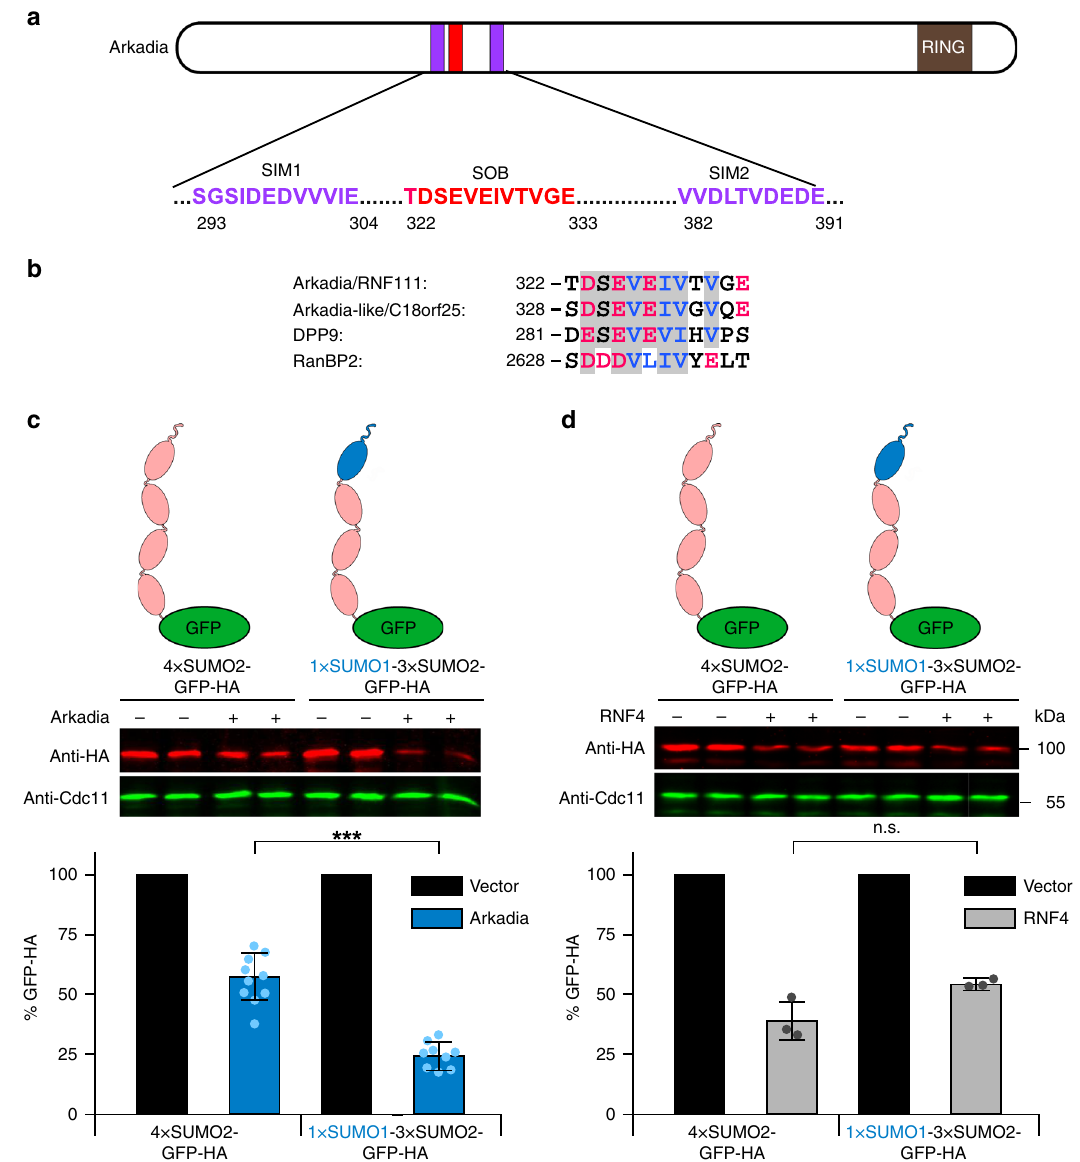
Fig. 1 Arkadia is a STUbL with a substrate preference distinct from RNF4. a Schematic representation of relevant domains and their positions in human Arkadia. b Alignment of SUMO-binding motifs from Arkadia, Arkadia-like 1 (ARKL1), DPP9, and RanBP2. Residues that are similar in at least the fi rst three of the molecules are shaded in gray. Acidic residues are shown in red, hydrophobic residues are shown in blue. c Analysis of substrate targeting by Arkadia upon expression in S. cerevisiae . HA-tagged GFP test substrates fused with their N-terminal ends to either 4xSUMO2 or a SUMO1-capped 3xSUMO2 chain were expressed in cells either transformed with an empty vector or with a plasmid expressing Arkadia. Cells were grown to log phase and extract proteins analyzed by quantitative anti-HA Western blotting. Endogenous Cdc11 protein levels were detected for normalization of loaded protein amounts. The middle panels show the Western blot images obtained for two independent transformants of each plasmid combination. The bottom panels show the results of quanti fi cations obtained with data for nine independent transformants each. Bars represent the means. Standard deviations (SD) are indicated by error bars. d Same as in c , but for RNF4 obtained with three independent transformants each. Three asterisks indicate signi fi cant differences with p -values < 0.001. n.s., not signi fi cant. Statistical signi fi cance was determined with unpaired and two-sided Student ’ s t -tests. Source data are provided as a Source Data fi